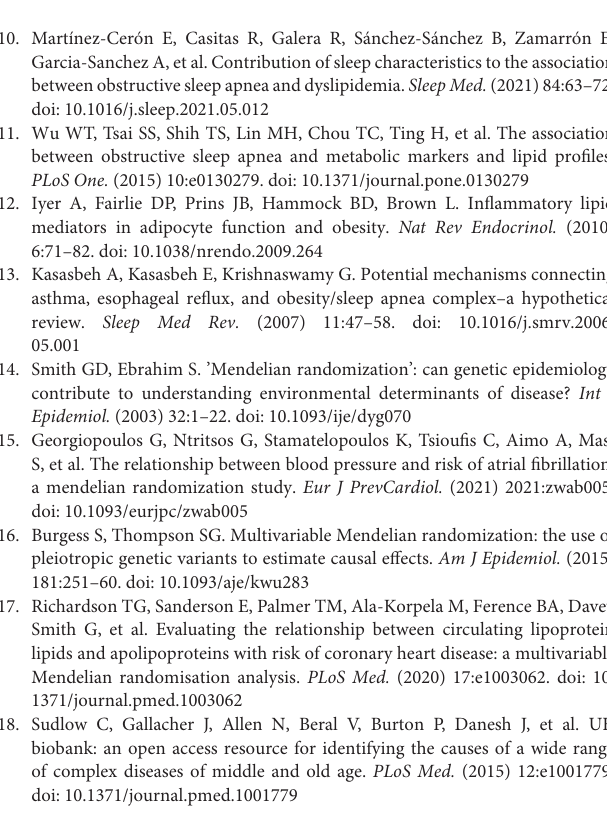
Supplementary Figure 1 | Forest plot. (A) Triglyceride, (B) high-density lipoprotein, (C) low-density lipoprotein, (D) apolipoprotein A-1, and (E) apolipoprotein B. Supplementary Figure 2 | Funnel plot. (A) Triglyceride, (B) high-density lipoprotein, (C) low-density lipoprotein, (D) apolipoprotein A-1, and (E) apolipoprotein B. Supplementary Table 1 | Removal of single nucleotide polymorphisms (SNPs) associated with potential confounders. Supplementary Table 2 | Final extracted